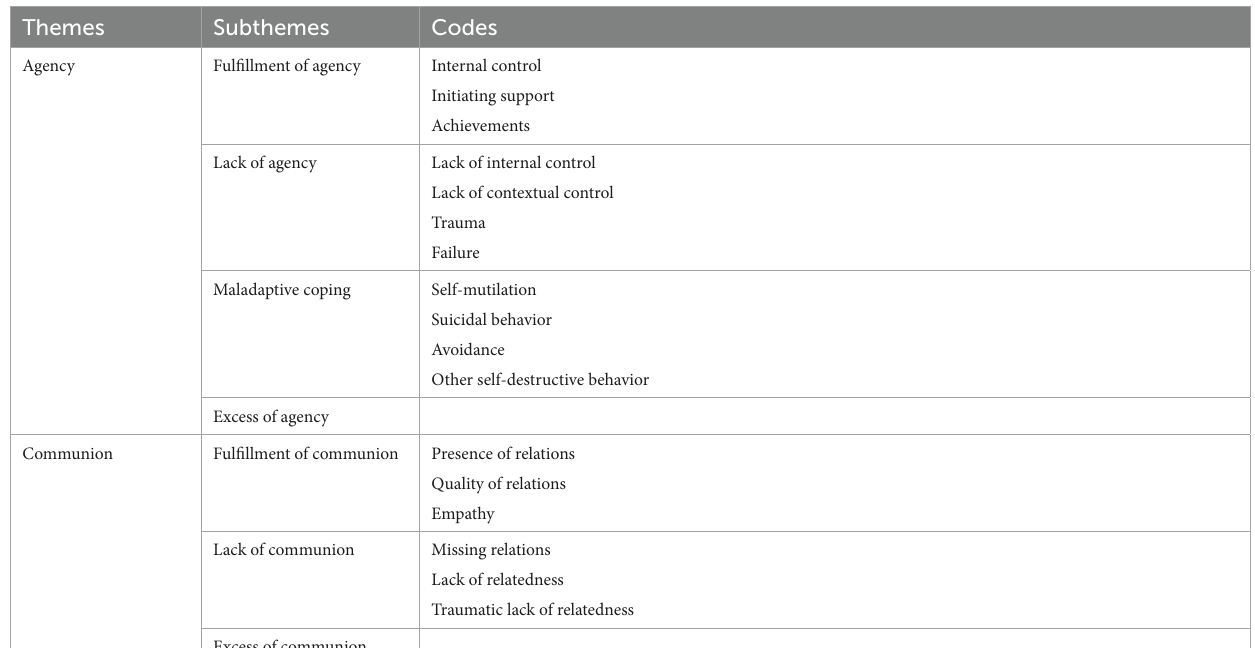
TABLE 1 Themes, subthemes and codes of deductive and inductive content